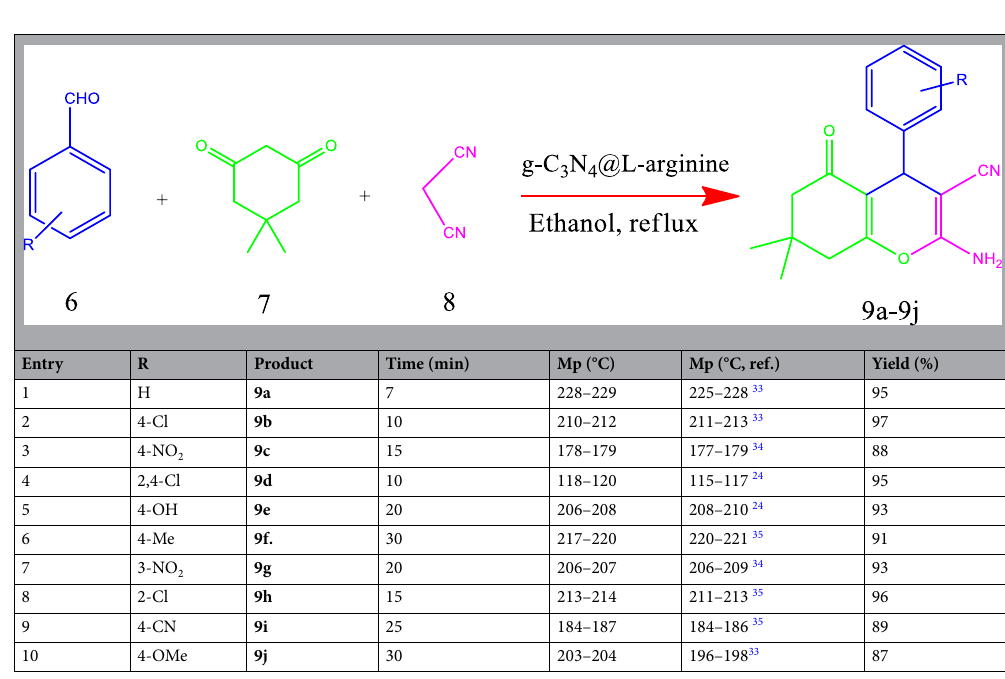
Table 3. Synthesis of 4 H -chromene derivatives using g-C 3 N 4 @l-arginine nanocatalyst. Reaction conditions: Reaction of benzaldehyde (1 mmol), dimedone (1 mmol), and malononitrile (1 mmol) g-C 3 N 4 @l-arginine (20 mg) and ethanol (7 mL) under reflux